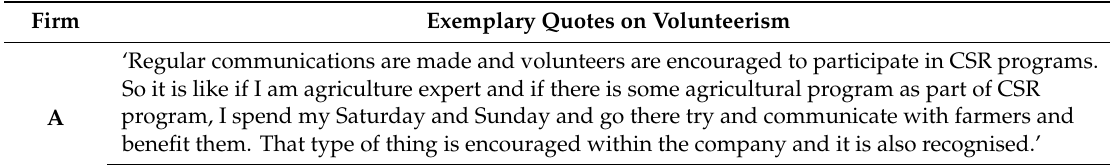
Table 2. Evidence of volunteerism as a part of organisational